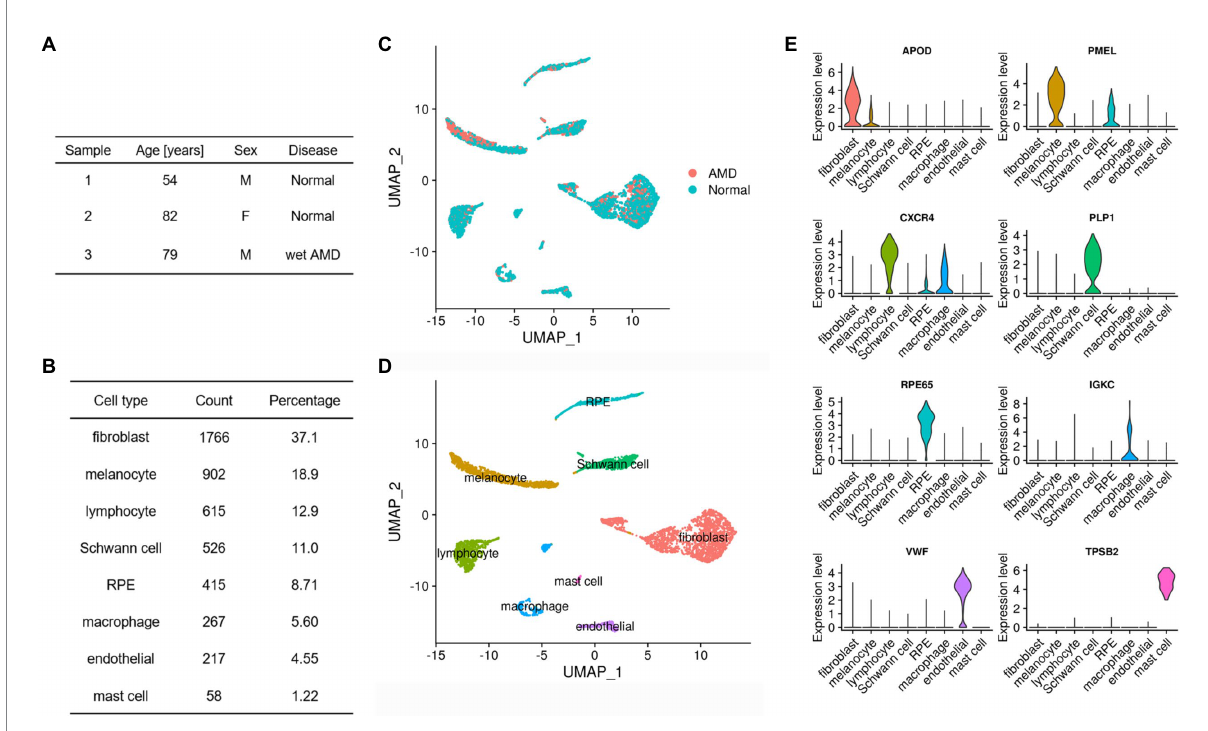
FIGURE 1 Summary of the RPE/choroid scRNA-seq dataset used for cell–cell communication analysis. (A) Demographic data including disease status of 3 RPE/choroid donors from GSE135922. (B) Count and percentage of each specific cell type detected from the 4,766 cells of the scRNA-seq data. (C,D) Dimensionality reduction (UMAP) of the scRNA-seq data showing eight cell types in the RPE/choroid. (C) Cells are colored by disease status (normal or AMD). (D) Cells are colored by cell-type annotations. (E) Violin plots showing the expression of marker genes used to annotate cell